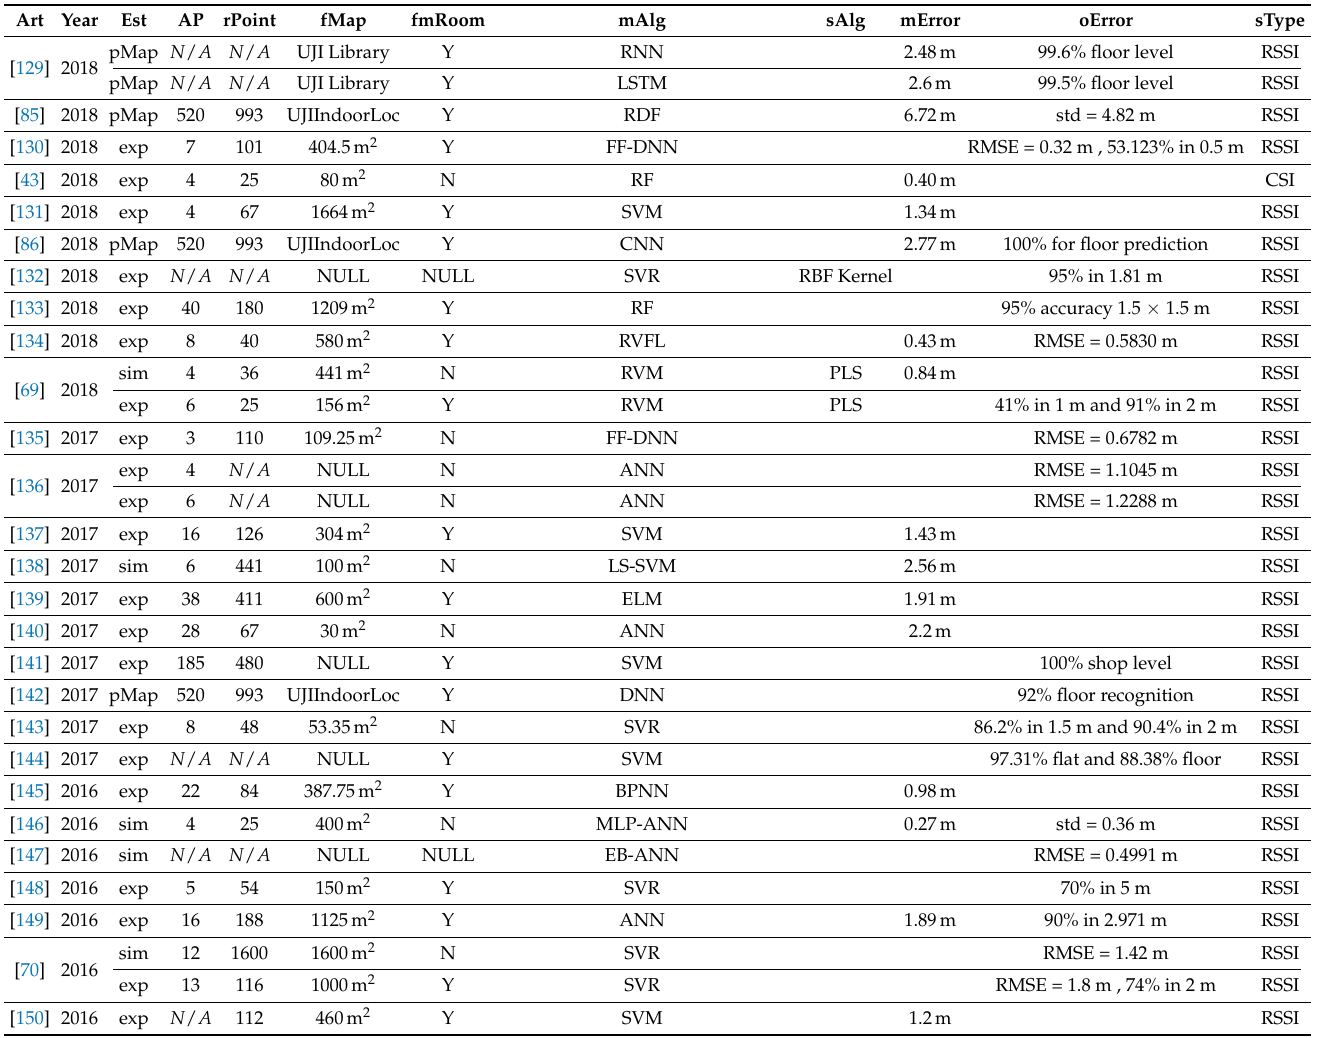
Table A4. Summary of reviewed